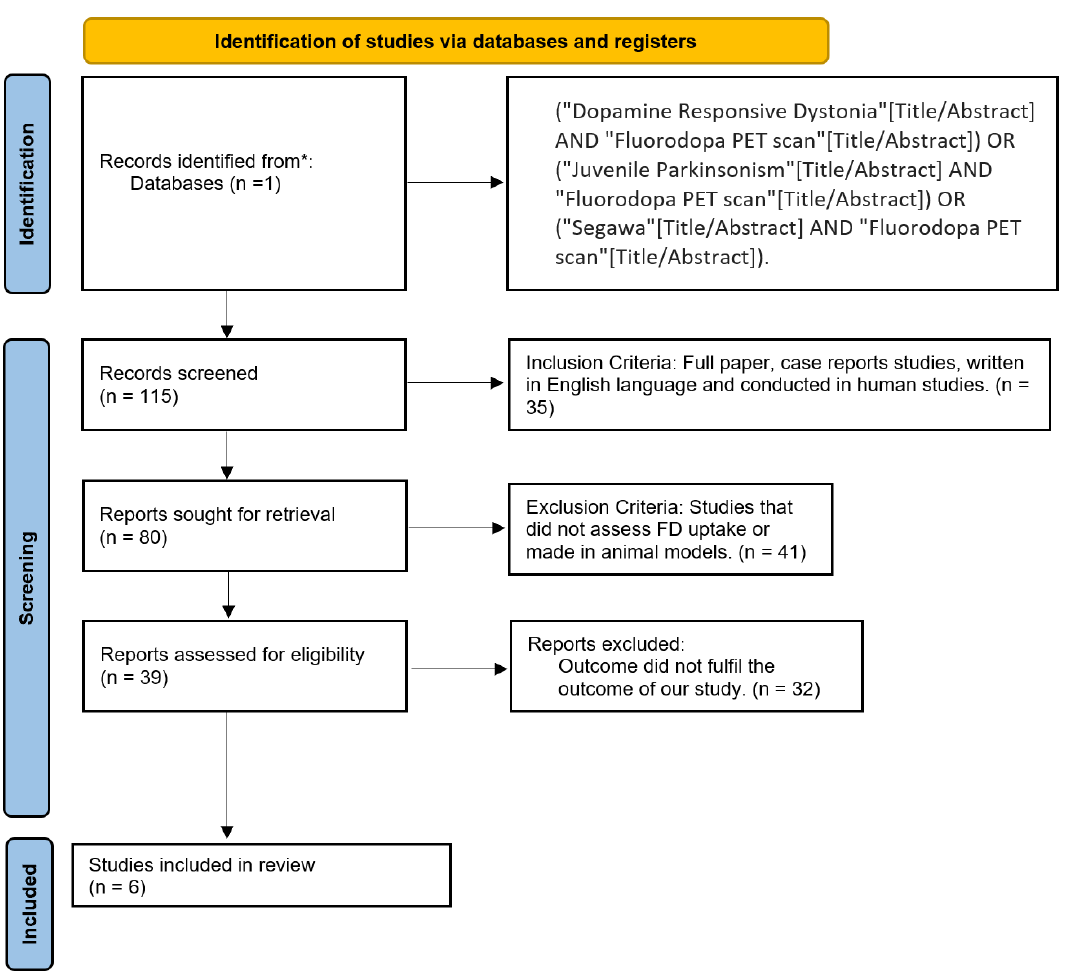
Figure 2. PRISMA flow chart. * Pubmed.